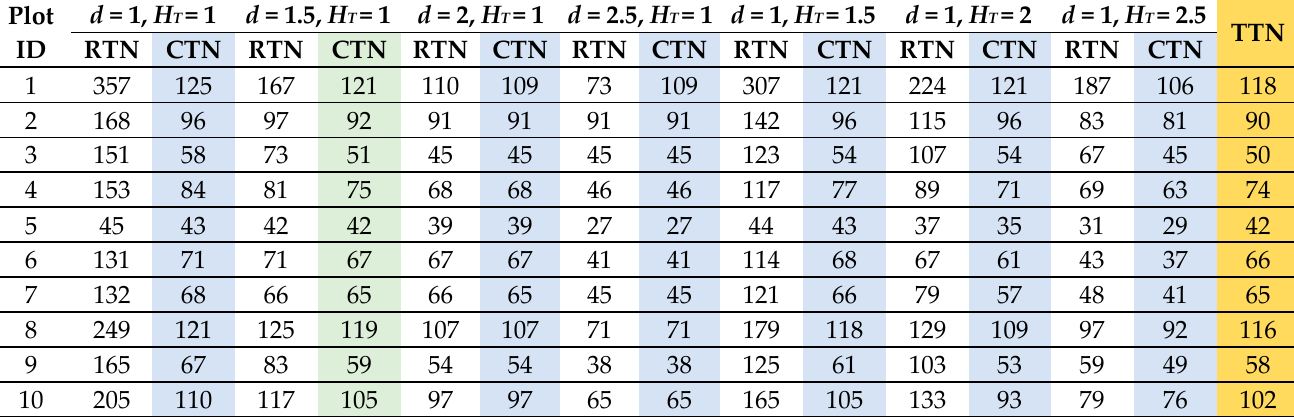
Note: RTN: Rough Tree Number, CTN: Calculated Tree Number, TTN: True Tree Number. It can be seen in Figure 16 that the blue curve represents rough tree numbers for each plot, the green dashed line represents the final calculated tree number obtained from the RPAA, and the orange curve represents the true tree numbers measured in the sample plots. The higher the coincidence degree of the green dashed line and the orange curve, the more reasonable the parameter d and H T settings are considered. Figure 16b has ideal results when d = 1.5 m and H T = 1 m. The result is more sensitive to the parameter H T and the parameter setting d = 1.5 m; H T = 1 m is more reasonable. When d = 1.5 and H T = 1, the green row is the ideal extraction result. All calculated tree numbers are larger than the true tree numbers in each plot, meaning some trees with huge crowns are divided into two trees and there are no missing trees; the average extraction error rate Rate error is 4.3% according to (8).